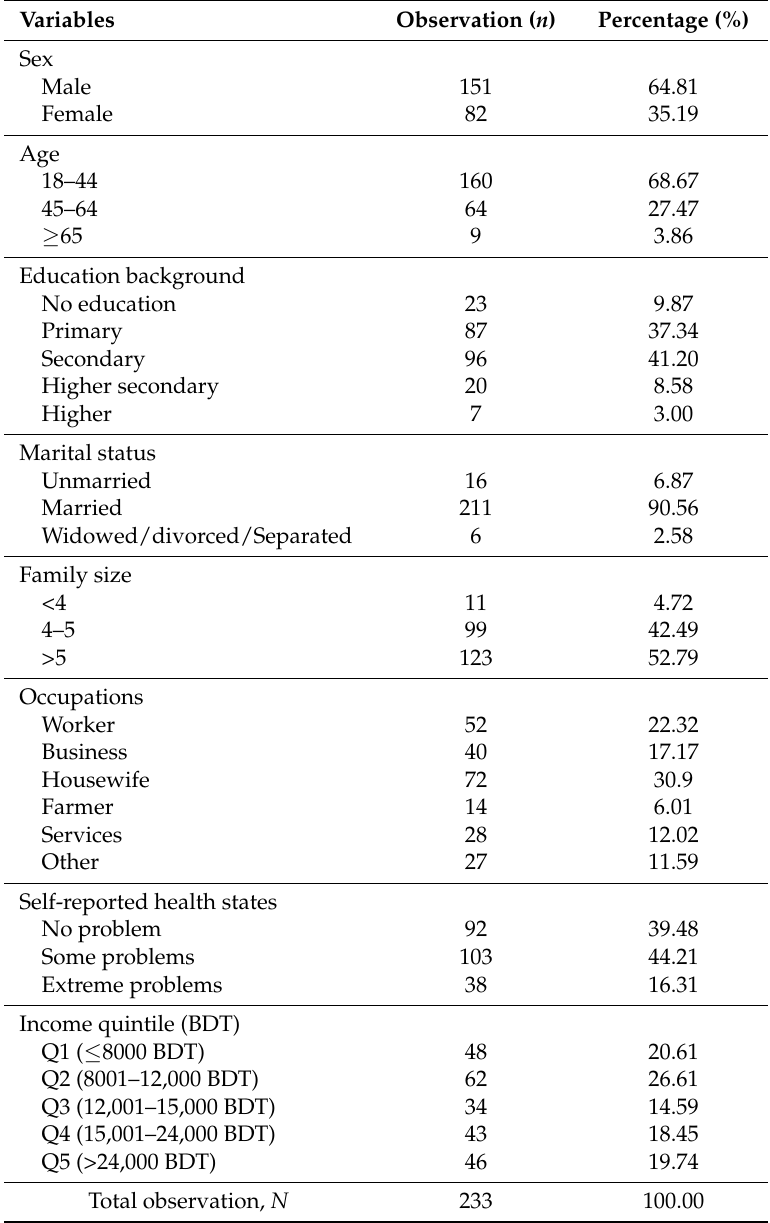
Table 2. Background characteristics of beneficiaries ( N =